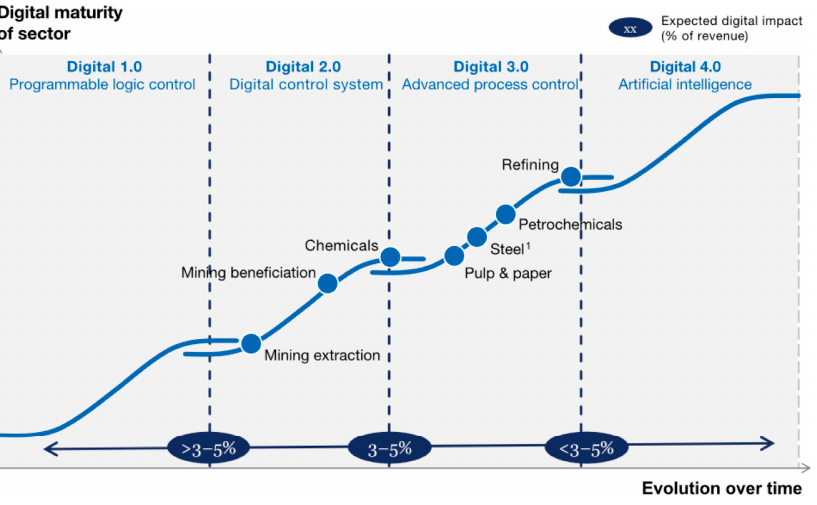
Figure 2. Comparison of digital maturity of mining and other industries, Steel 1 is used for example of non-extractive industry (Reprinted from Ref. [6]).